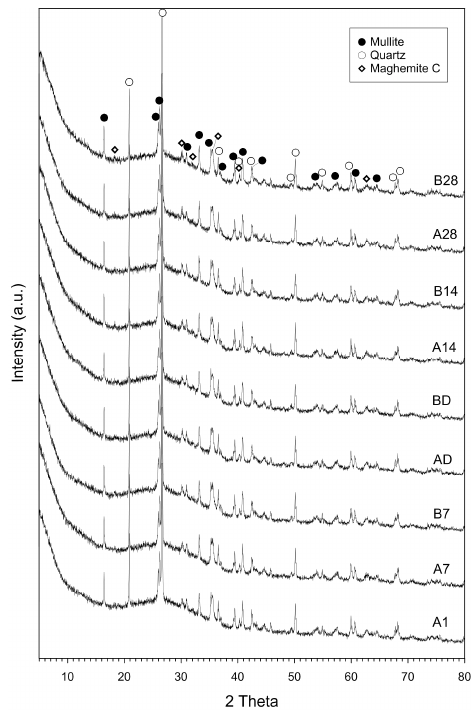
Figure 6. X-ray diffraction patterns of geopolymers described in Table 1. XRD patterns do not show any differences that could explain the substantial strength difference between the “A” and “B” series specimens.